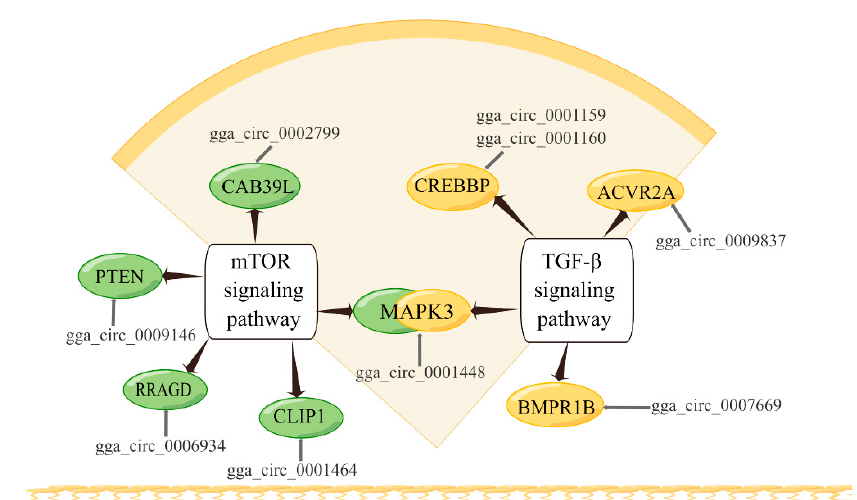
Figure 4. Skeletal-muscle-development-related pathways involved in differentially expressed mRNAs and Figure 4. Skeletal ‐ muscle ‐ development ‐ related pathways involved in differentially expressed mRNAs and DE ‐ circRNAs.